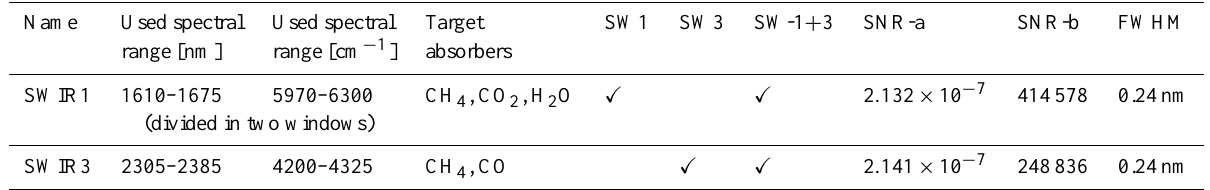
Table 1. Characteristics of simulated measurements and retrieval simulations. We investigate three retrieval configurations (SW1, SW3, and SW1+3) that take into account the possible combinations of band SWIR1 and SWIR3. For each channel, the signal to noise ratio (SNR) √ aR + b with R the backscattered radiance in units [photons · s − 1 cm − 2 sr − 1 nm − 1 ] and empirical is modeled according to SNR = aR/ parameters a and b (included on the Table as SNR-a and SNR-b). The full width at half maximum (FWHM) defines the width of the Gaussian instrument response function which is sampled by 2.65 pixels for each